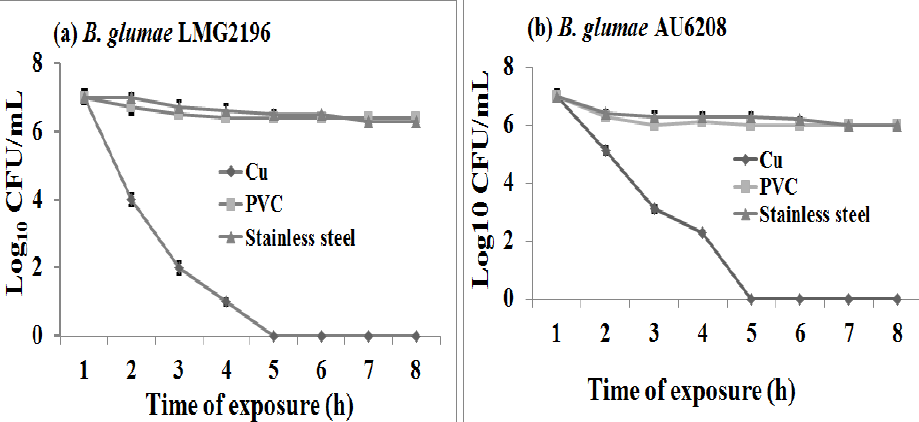
Figure 1. Survival of Burkholderia glumae strains ( a ) LMG2196 and ( b ) AU6208 on copper, PVC and steel surfaces, respectively, within 8 h of contact time. The initial concentration of bacterial suspensions was 5 × 10 7 CFU/mL. The plots showed a significant difference ( p < 0.05) in the logarithms of the surviving bacterial counts (CFU/mL) between copper and control surfaces regardless of the bacterial